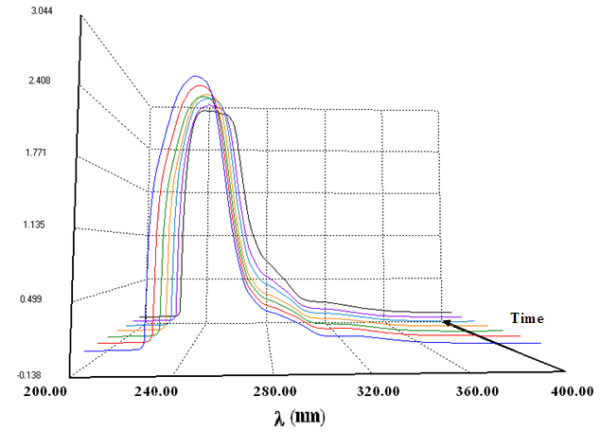
Change in the absorption spectra with time using VOL1.